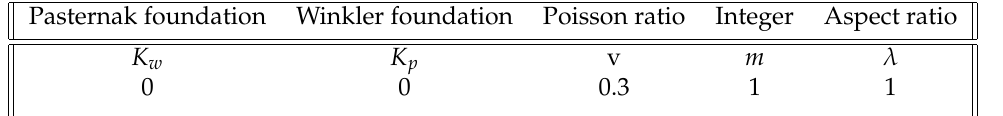
Table 1 contains parameters for validation of the approach to ascertain the correctness of the